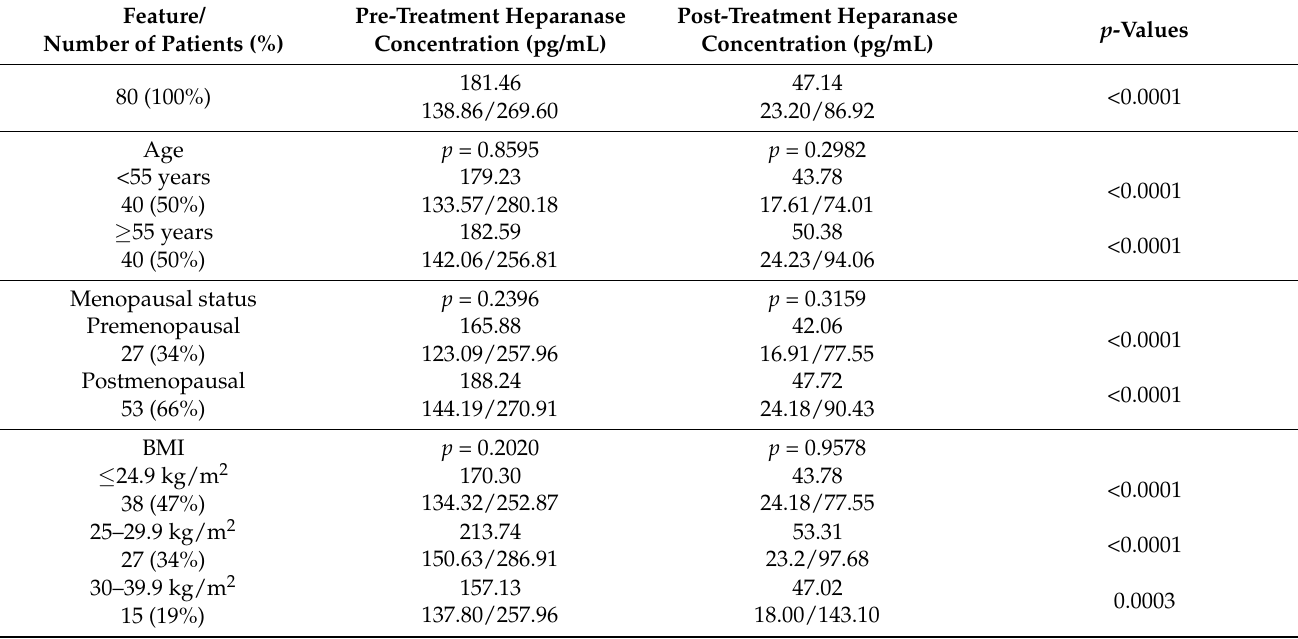
Table 1. The impact of adjuvant treatment on the heparanase concentration with respect to age, menopausal status, body mass index (BMI).